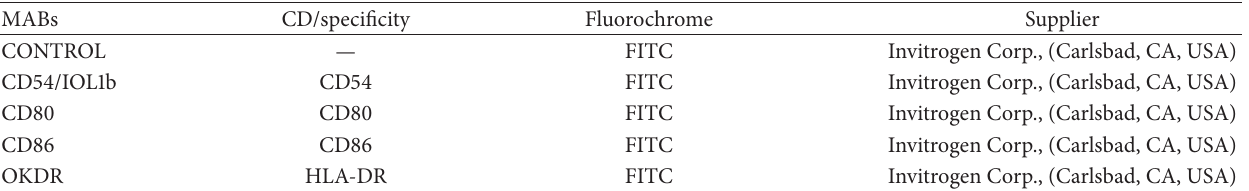
Table1:Monoclonalantibodies(MABs)usedtostudytheeffectofdexketorpofen,ketorolac,metamizole,andacetylsalicylicacidonantigenic